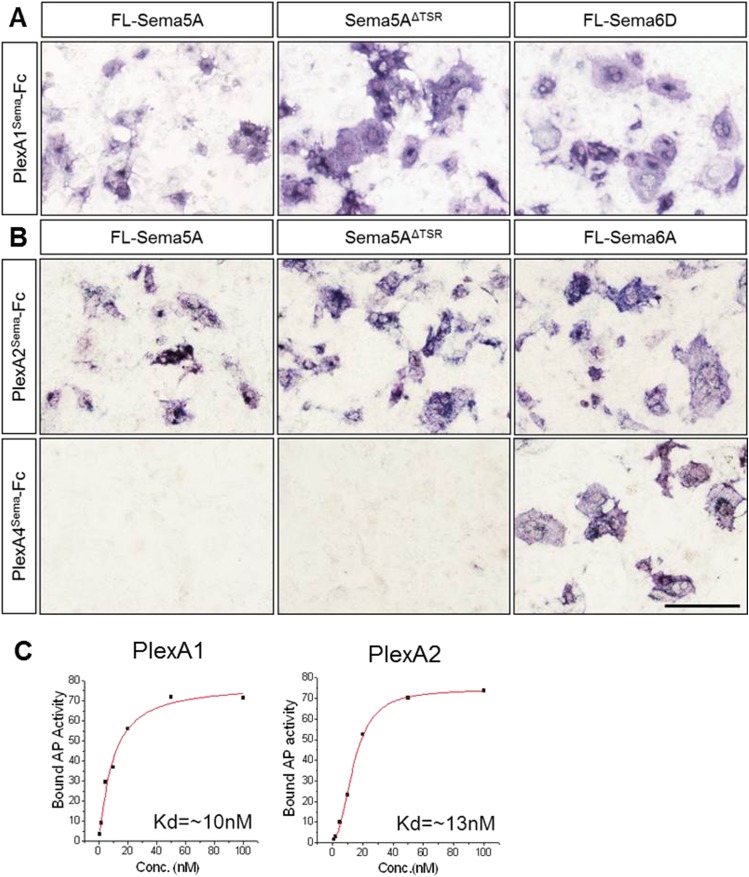
Molecular basis of PlexA1 and PlexA2 binding to Sema5A.Full-length Sema5A (FL-Sema5A), a membrane bound Sema5A deletion construct that lacks the seven thrombospondin type-1 repeats (Sema5AΔTSR), or class 6 semaphorins, were expressed in transiently transfected COS7 cells and assayed for binding of soluble PlexASema-Fc fusion protein oligomerized with an anti-Fc antibody conjugated to human alkaline phosphatase. (A) The sema-domain of PlexA1 (PlexA1Sema-Fc) binds to membrane bound FL-Sema5A, Sema5AΔTSR, and FL-Sema6D. (B) PlexA2Sema-Fc, but not PlexA4Sema-Fc, binds to Sema5A and SemaS5AΔTSR expressed on the surface of COS7 cells. Sema6D is shown as a positive control for PlexA1Sema-Fc binding, and Sema6A is shown as a positive control for PlexA2Sema-Fc and PlexA4Sema-Fc binding. Collectively, these binding studies reveal that the sema-domain of Sema5A interacts with the soluble sema domains of PlexA1 and PlexA2, but not PlexA4. (C) Saturation binding curve of Sema5A-Fc binding to COS7 cells expressing PlexA1 or PlexA2. For quantification of binding, Sema5A-Fc was oligomerized with anti-Fc conjugated to human placental alkaline phosphate. The calculated dissociation constants (KD) for the Sema5A/PlexA1 and the Sema5A/PlexA2 interactions are 10 nM and 13 nM, respectively. Scale bar = 50 μm.